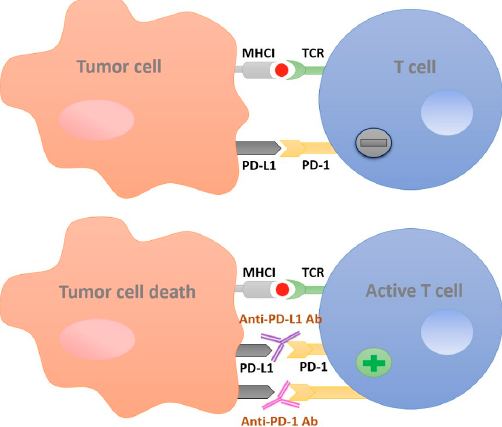
Figure 1. Diagram depicting the anticancer mechanism of PD-1/PD-L1 inhibitors. Tumor cells escape from the anti-tumor activity of T cells by the binding of PD-L1 to the PD-1 receptor. PD-1 or PD-L1 antibodies block the binding of PD-L1 on tumor cells to PD-1 receptors on T cells, which allows T cells to induce the immune response against tumor cells. MHCI, Major histocompatibility complex I; TCR, T cell receptor; PD-L1, Programmed death-ligand 1; PD-1, Programmed death-receptor 1; Ab,